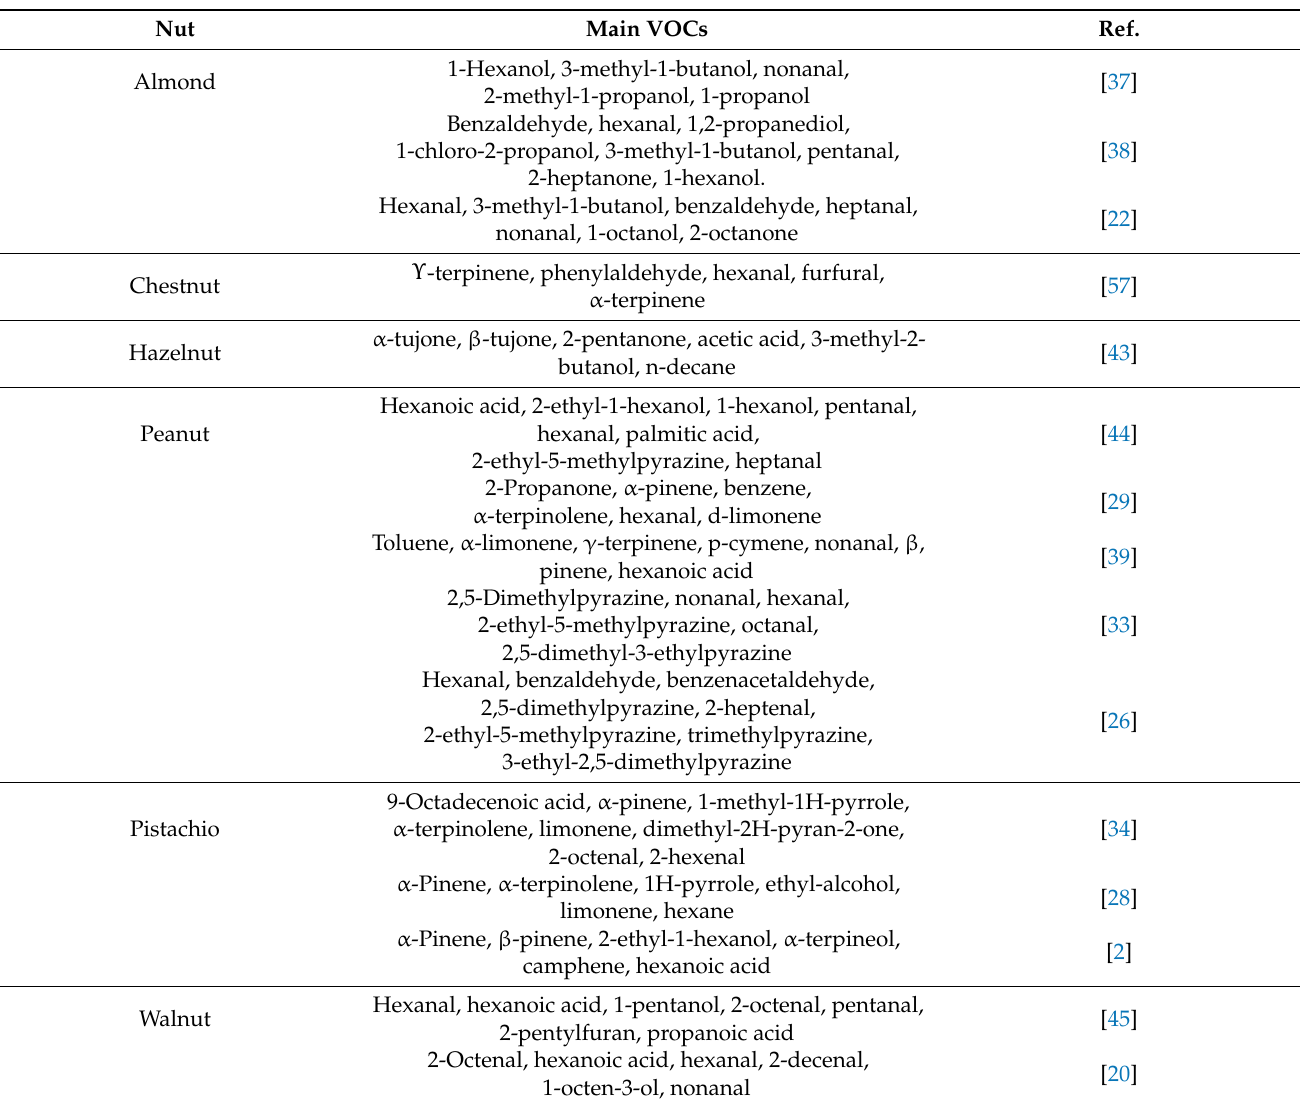
Table 2. Main VOCs of raw nuts.